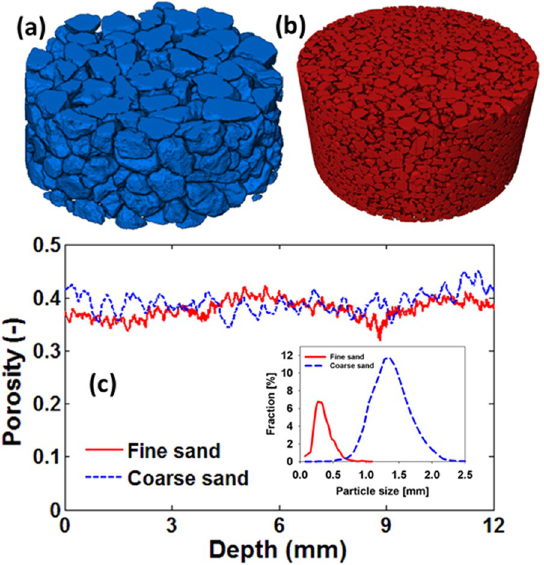
Figure 1. Three-dimensional rendering of the reconstructed volume of the packed ( a ) coarse and ( b ) fine sands with the corresponding porosity presented in ( c ). The inset shows the particle-size distributions of the sand grains used in the